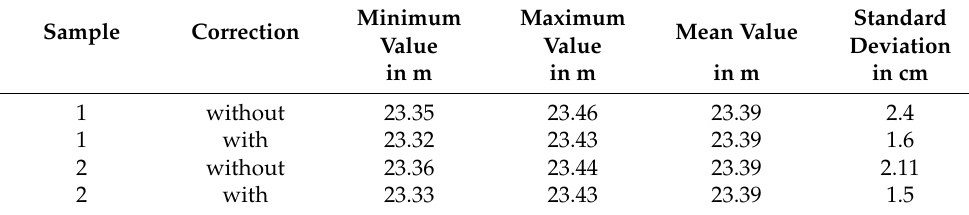
Table 3. Properties of the measured value series before and after deviation correction.